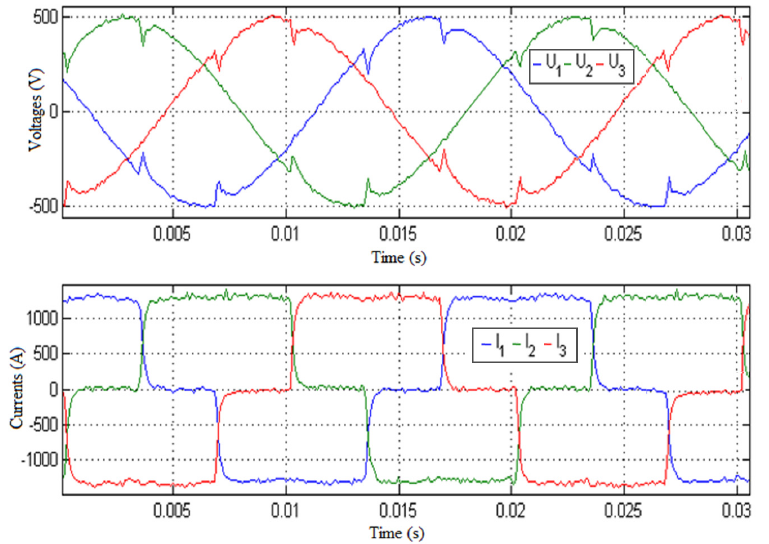
Figure 3. The three-phase voltages and currents acquired in the secondary winding of the transformer for excitation supply.